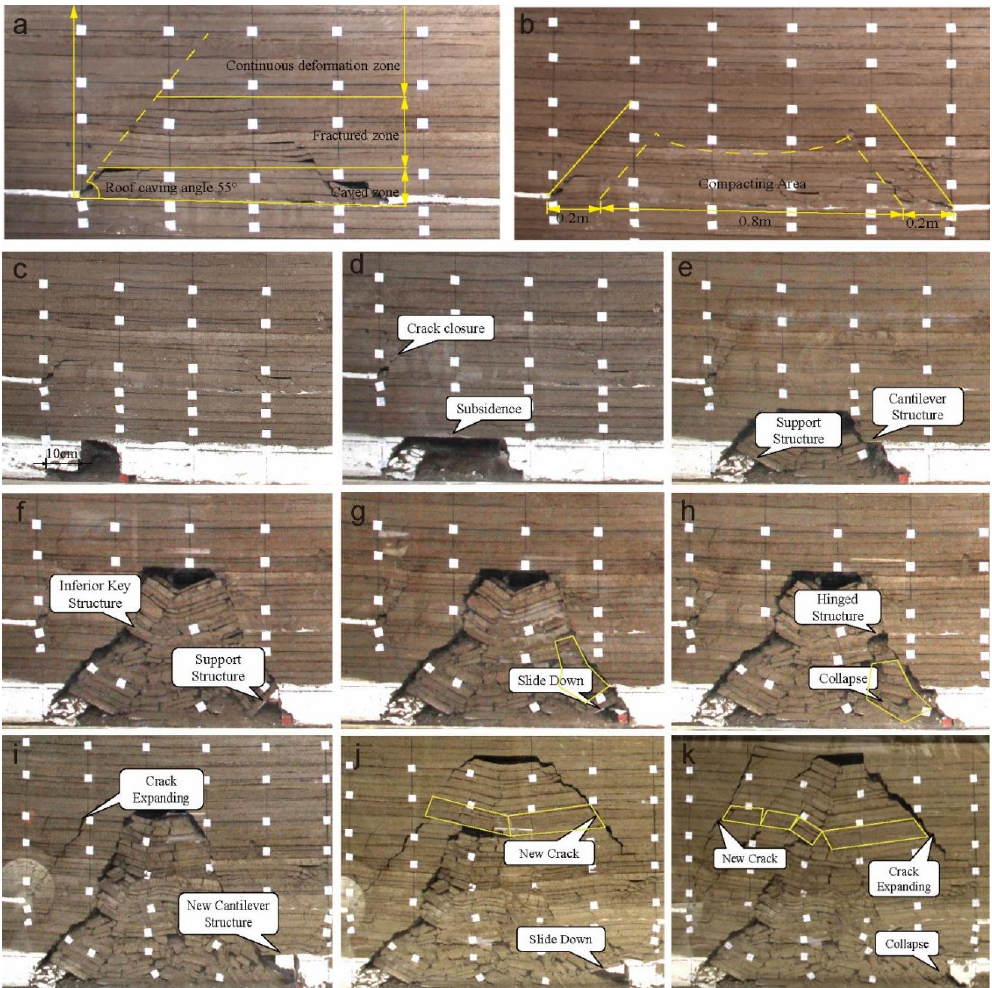
Figure 5. Roof strata behavior of the LTCC panel under an igneous sill and upper gob.